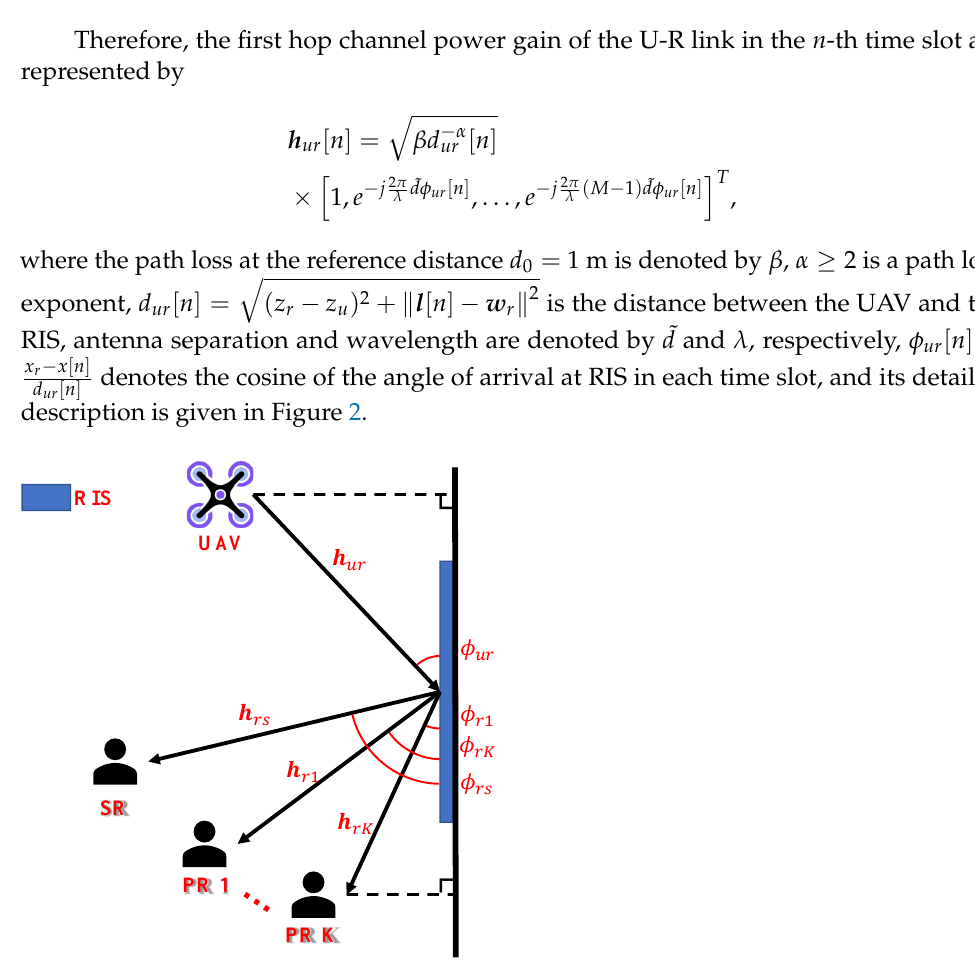
Figure 1. The RIS-enabled UAV CR scenario.